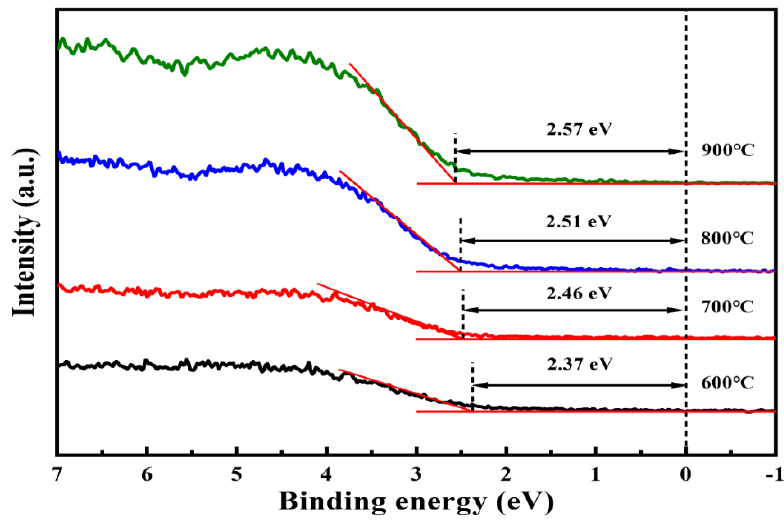
Figure 7. Valence band spectra of AZO gate dielectrics on silicon substrates.